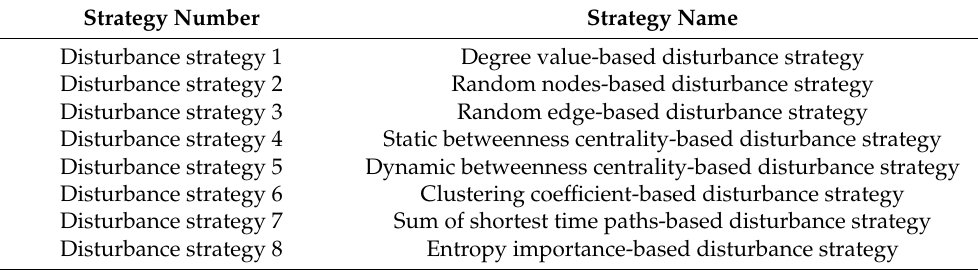
Table 1. Summary of disturbance strategy